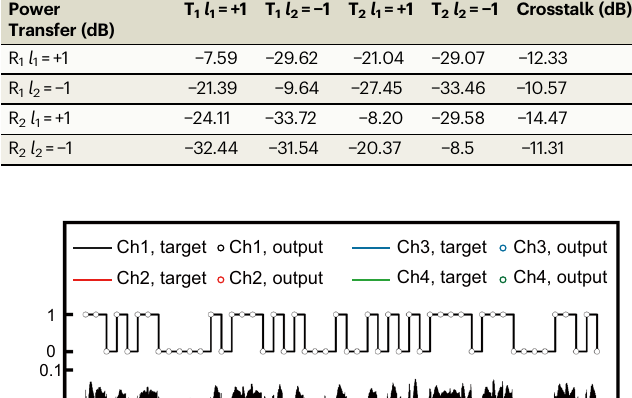
Table 1 | Power transfer and total crosstalk of each OAM channel Power Transfer (dB)